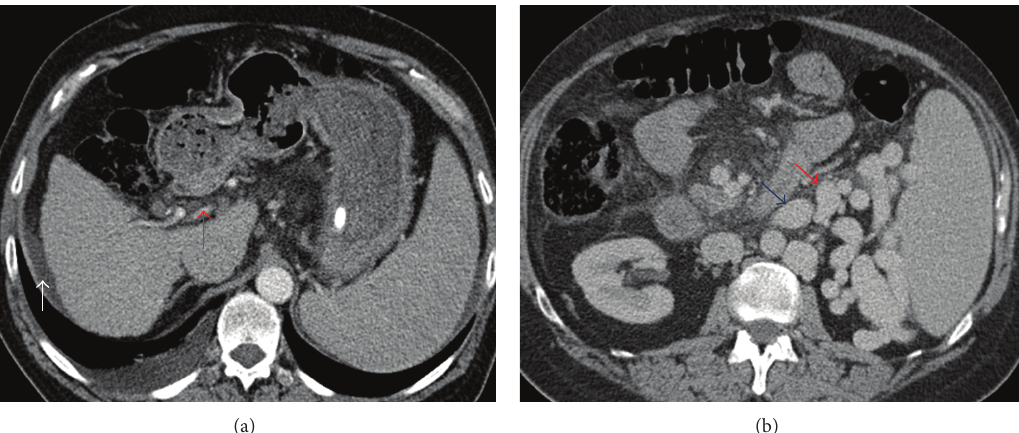
Figure 1: (a) Axial contrast-enhanced CT demonstrates diminutive portal vein (red arrow) and minimal perihepatic ascites (white arrow). (b) Axial CT demonstrates enlarged spleen with multiple perisplenic collateral vessels. A large splenorenal shunt (red arrow) is seen arising from a dilated left renal vein (blue arrow).